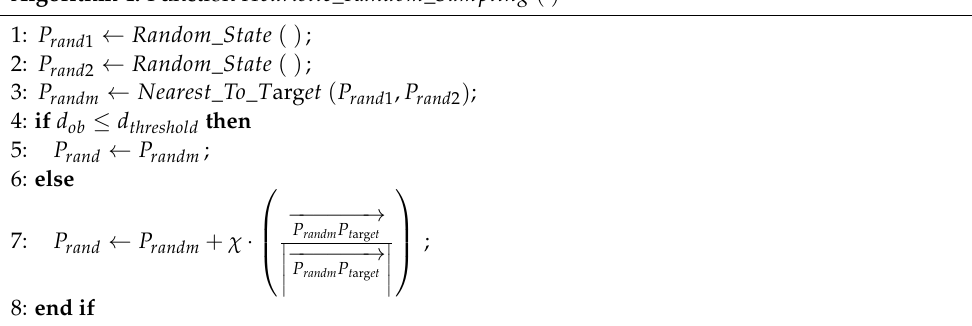
Algorithm 4: Function Heuristic _ Random _ Sampling (